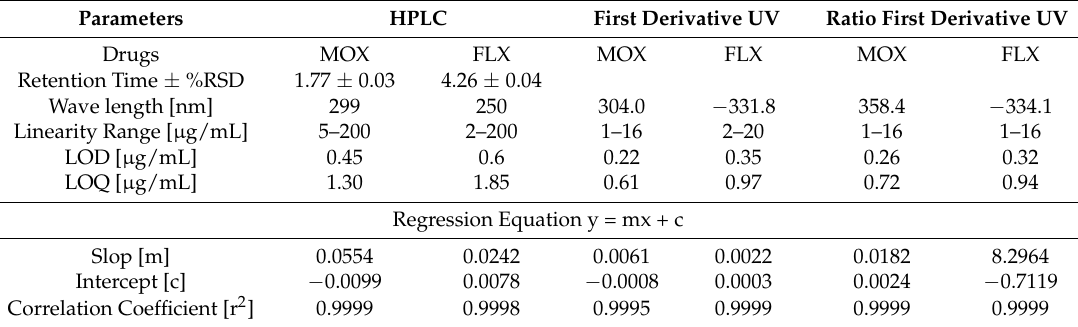
Figure 6. Standard Calibration curve for MOX and FLX by RP HPLC( A ), First derivative ( B ), and ratio first derivative UV spectrophotometry ( C and D ). Table 1. Regression equations and validation parameters results for MOX and FLX.